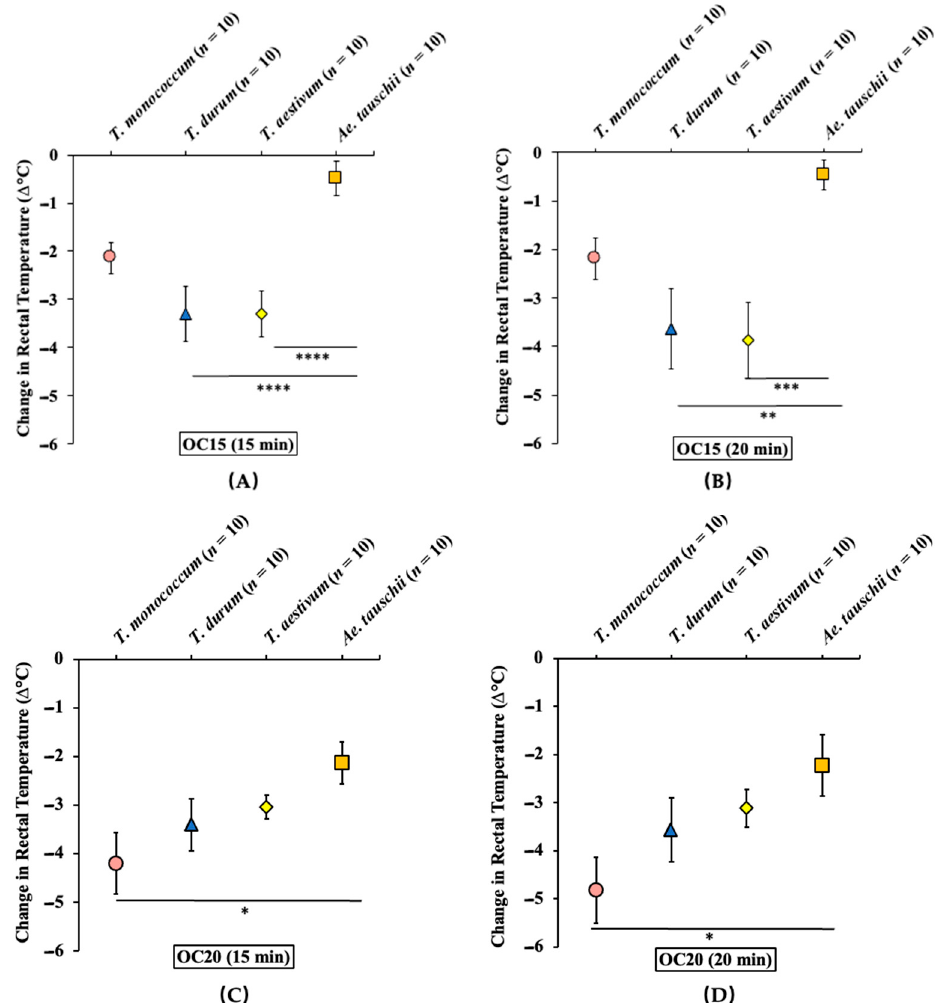
Figure 11. Comparative map of the intrinsic allergenicity disease elicitation potential of SSPEs from diploid, tetraploid, and hexaploid wheat. ( A , B ) HSRs at 15 min and 20 min after oral challenge doses of 15 mg (OC15) SSPE of diploid, tetraploid, and hexaploid wheat. ( C , D ) HSRs at 15 min and 20 min after oral challenge doses of 20 mg (OC20) of diploid, tetraploid, and hexaploid wheat. * p < 0.05, ** p < 0.01, *** p < 0.005, **** p < 0.001, one-way ANOVA and Tukey’s post hoc tests. n : number of mice, SSPE: salt-soluble protein extract, HSR: hypothermic shock response. mice, SSPE: salt-soluble protein extract, HSR: hypothermic shock